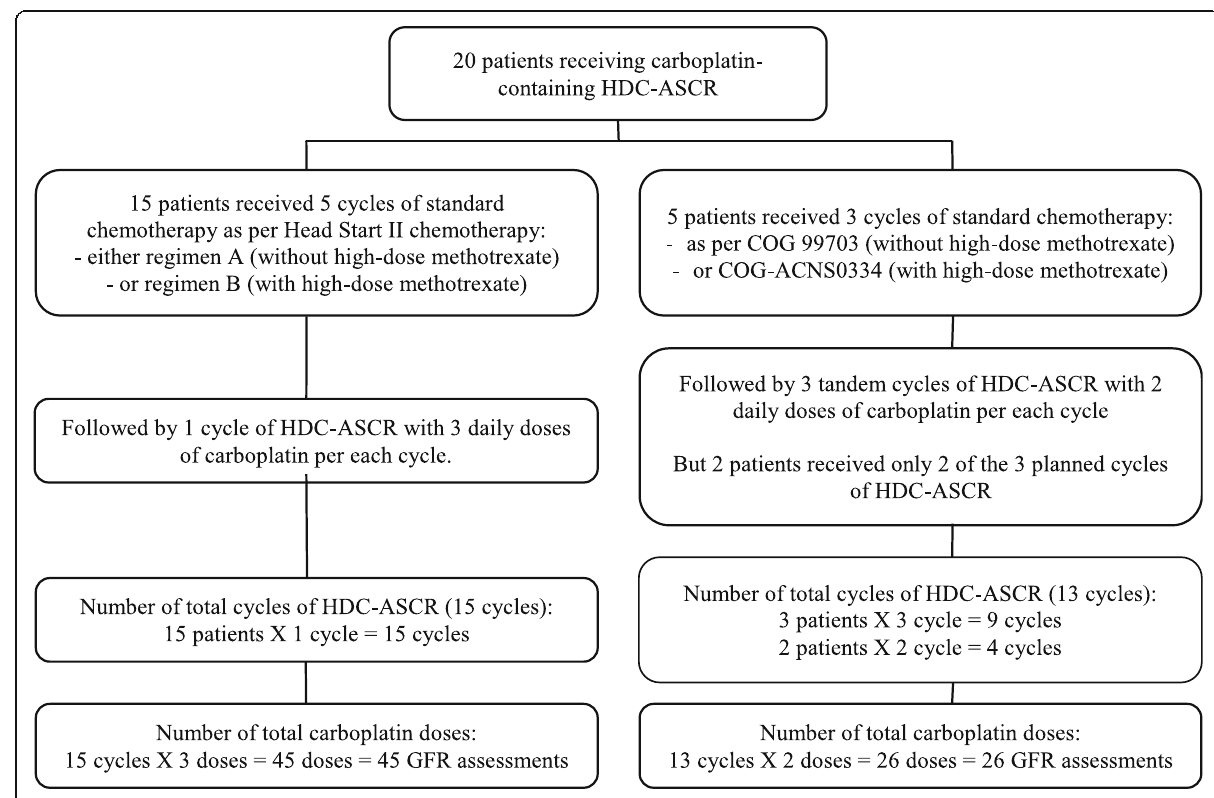
Fig. 1 Different approaches using HDC-ASCR to treat pediatric brain